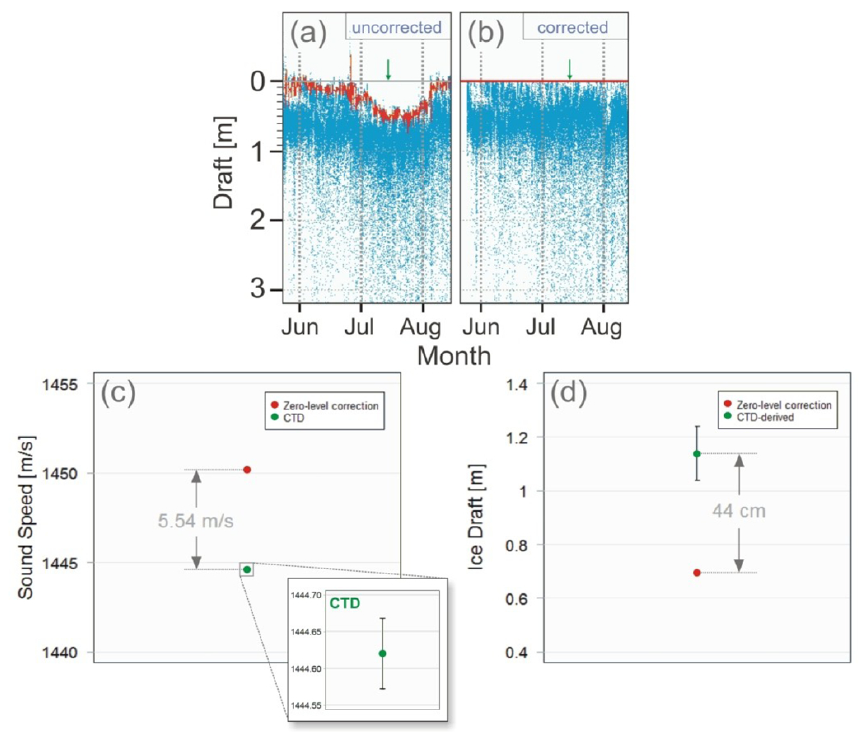
Figure 7. (a) Pseudo draft of AWI 231-7 in winter 2006 (sample rate: 4min, ULS depth: 125m). The red line depicts the interpolated zero line through ice draft minima. The green arrow marks the time of CTD measurement. (b) Corrected ice draft with the interpolated line levelled to zero draft. (c) Mean sound speed calculated from a CTD measurement on 13 July 2006, 20:03:00, and mean sound speed that would be needed to obtain the corrected ice draft in (b) at the same time with the respective ULS parameters. The error bars on the sound velocity were obtained by calculating an error propagation for the sound speed equation of Mackenzie (1981) and using salinity, temperature and depth from CTD. (d) Corrected ice draft on 13 July 2006 at the time of the CTD measurement, and ice draft calculated with the CTD-derived sound speed. The error bars of the ice draft were obtained through error propagation, using the uncertainty ∆ c from the CTD sound speed in (c) and neglecting ∆ ρ